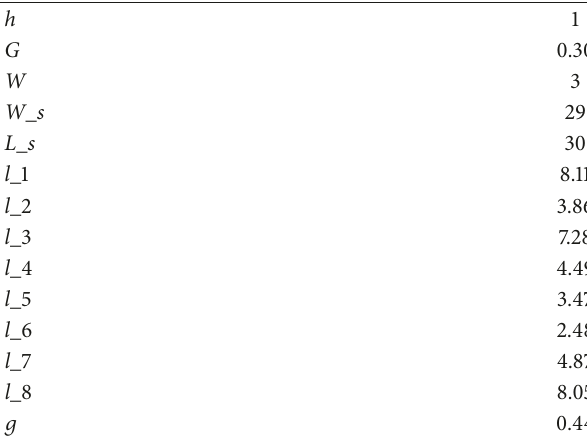
Table 2: The optimal parameters of the 3-dB CPW power splitter (unit: mm).